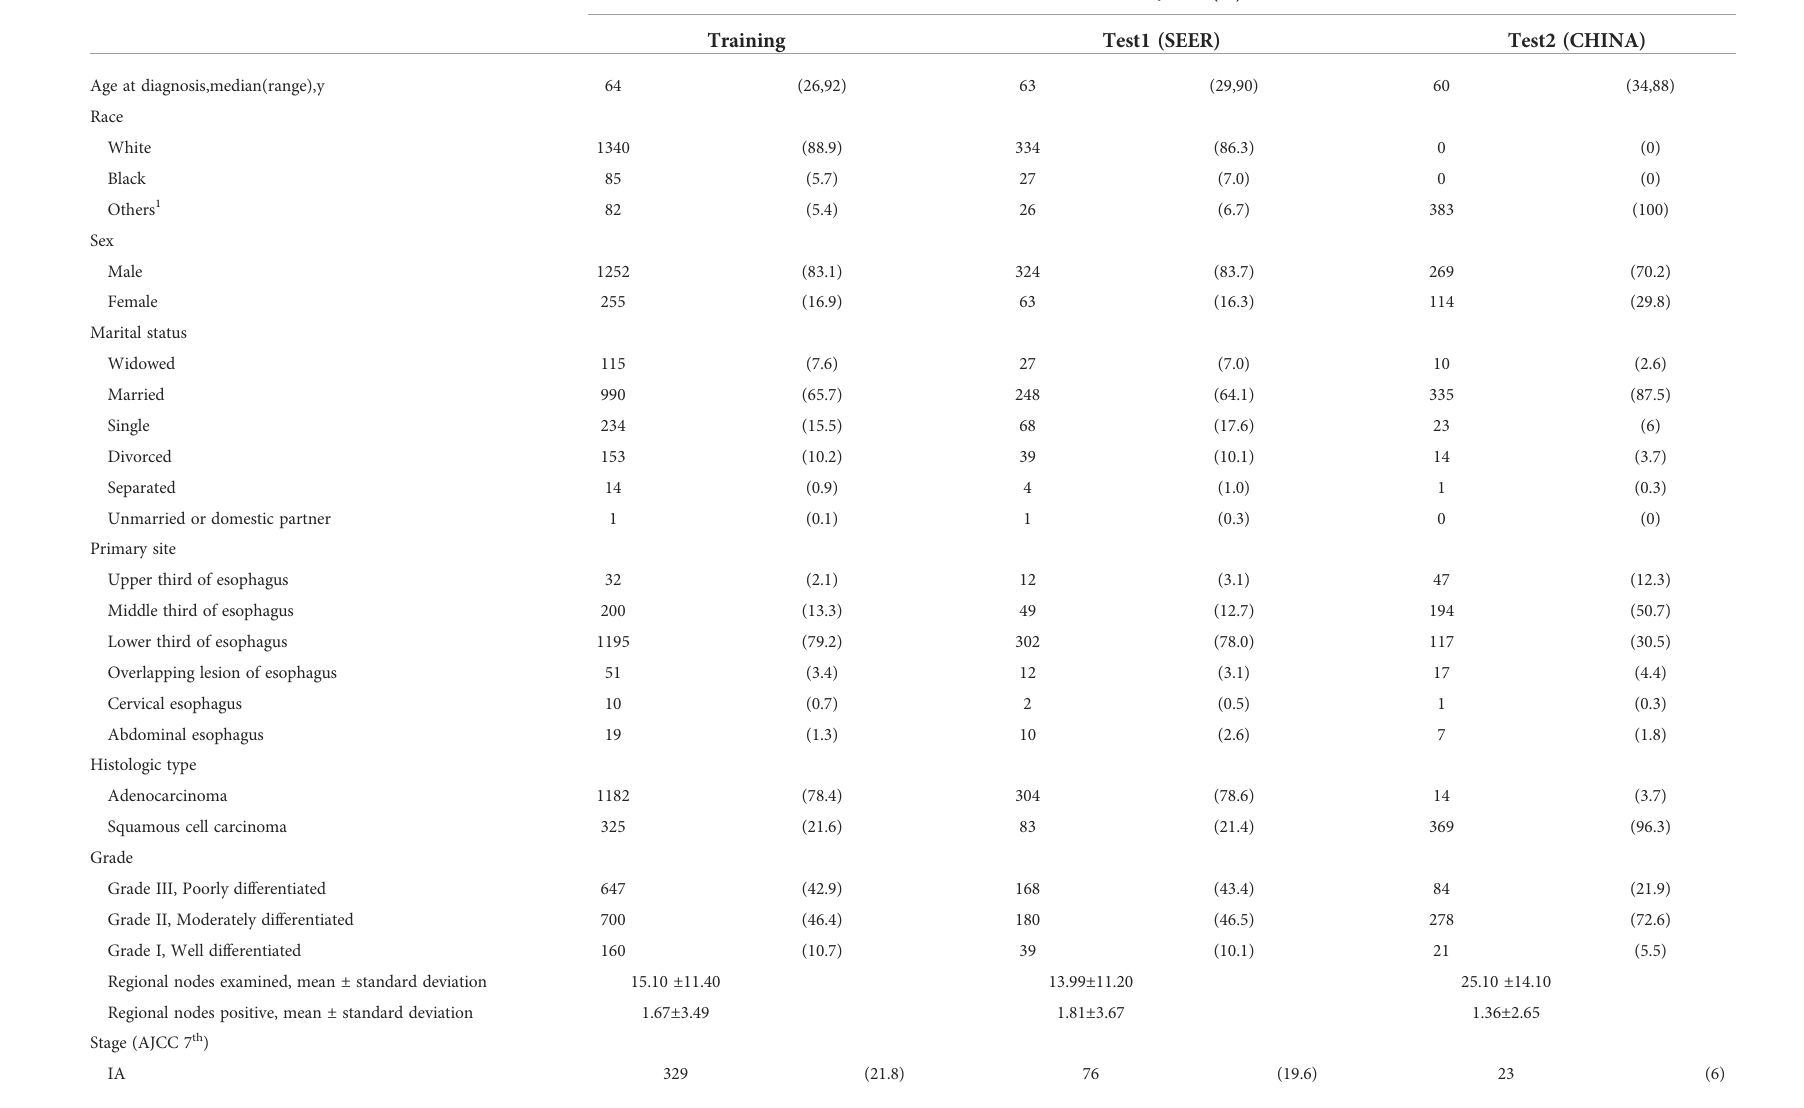
TABLE 3 Characteristics of patients in the whole data set of treatment recommendation.